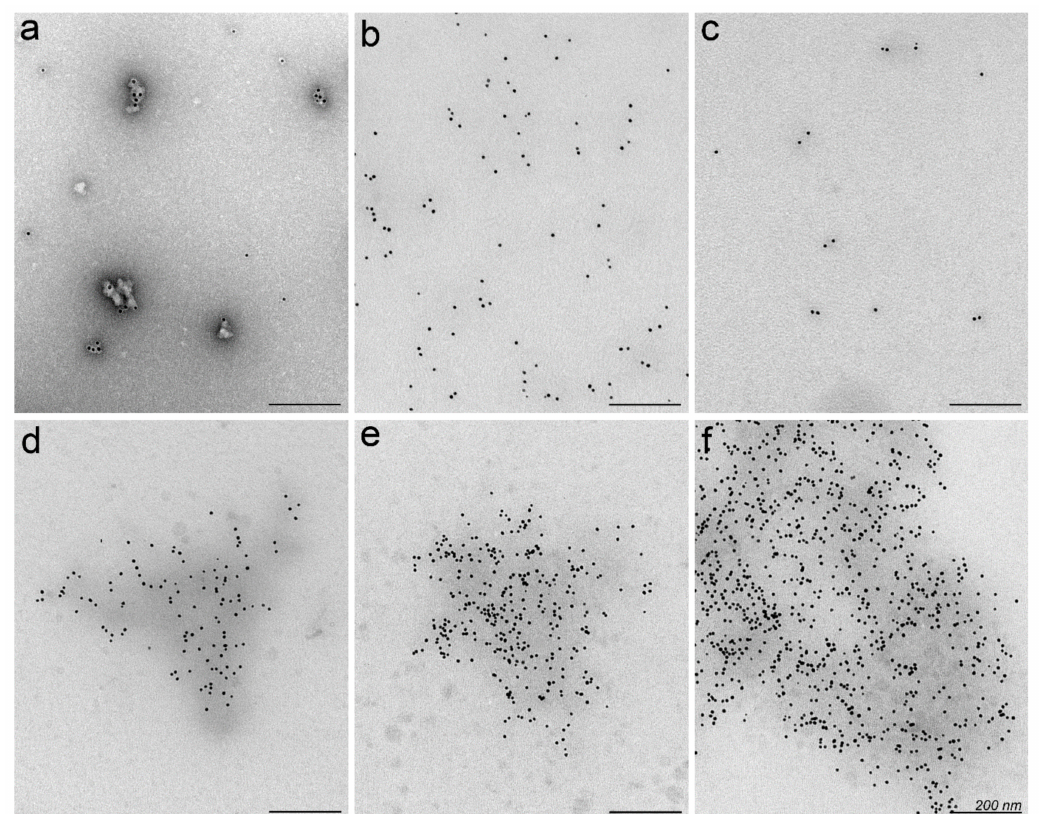
Figure 2. Visualisation of PF14-SCO nanoparticles and protein corona by transmission electron microscopy (TEM). Com- plexes of PF14 and biotin-SCO labelled with colloidal gold of 10 nm diameter (black dots) were formed in water at PF14/SCO molar ratio 5. PF14-SCO complexes without protein corona negatively stained with uranyl acetate on TEM grid ( a ), and in unstained specimen ( b ). Biotin-SCO labelled with colloidal gold and stained with uranyl acetate ( c ). Protein corona forming in 50% bovine ( d ), murine ( e ) or human serum ( f ) clusters PF14-SCO nanoparticles to conglomerates with electron dense background. Scale bar: 200 nm. Representative images from three independent experiments are